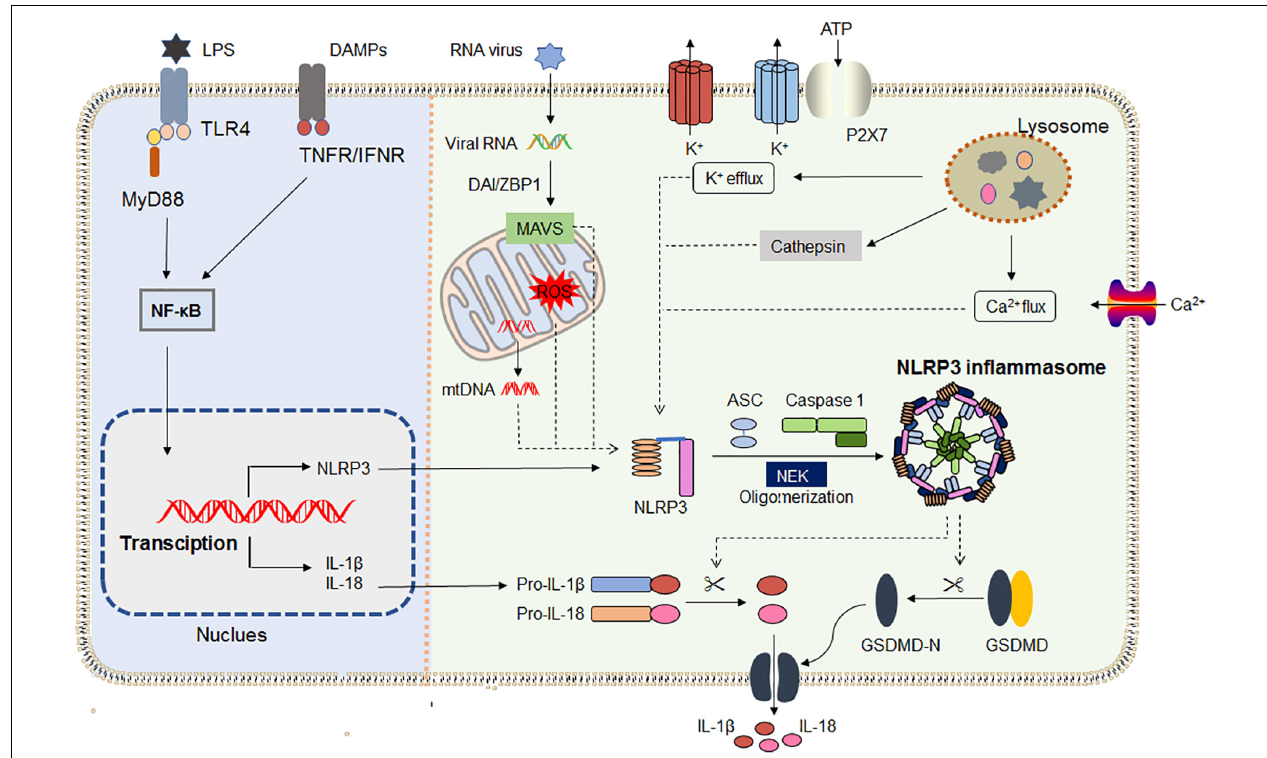
FIGURE 1 | NLRP3 inflammasome priming and activation. The priming (left) is provided by activation of pathogen-associated molecular patterns (PAMPs) or cytokines, leading to the transcriptional upregulation of NLRP3, IL-1, and IL-18 in a NF- κ B-dependent way. Those genes’ transcriptions are induced through the recognition of engage pattern-recognition receptors. Activation (right) is provided by any numerous PAMPs or damage-associated molecular patterns (DAMPs), such as particulates, ATP, crystals, and pathogens, which activate multiple upstream signaling events including K + efflux, Ca 2 + flux, Cl - efflux, lysosomal disruption, ROS production, and mtDNA. All signals induce NIMA-related kinase 7 (NEK7) to bind with NLRP3, and then initiate inflammasome assembly. Assembly of the NLRP3 inflammasome leads to autoproteolytic cleavage of pro-caspase 1, and the activated caspase 1 mediates the release of the inflammatory cytokines IL-1 β and IL-18, as well as GSDMD-mediated pyroptosis. IFNAR, IFN α / β receptor; IL-1R1, IL-1 receptor type 1; NF- κ B, nuclear factor- κ B; NEK7, NIMA- related kinase 7; MAVS, antiviral signaling protein; DAI/ZBP1, DNA-dependent activator of IRFs/Z-DNA binding protein